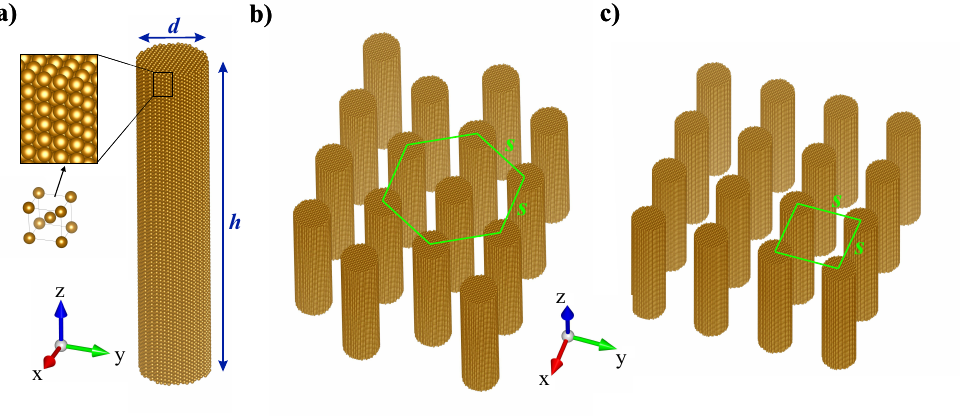
Figure 1. Graphical visualization of the investigated structures used in the calculations: ( a ) single cylindrical nanostructure (the magnification shows packing arrangement of atoms in considered bcc iron structure), ( b ) hexagonal arrangement of nanostructures and ( c ) square arrangement of nanostructures. The wire axis for all structures is along Oz direction. The notation means as follows: d is the diameter of nanowires, h is the length of nanowires and s is center-to-center distance between neighboring nanowires. All structures were rendered using VESTA software